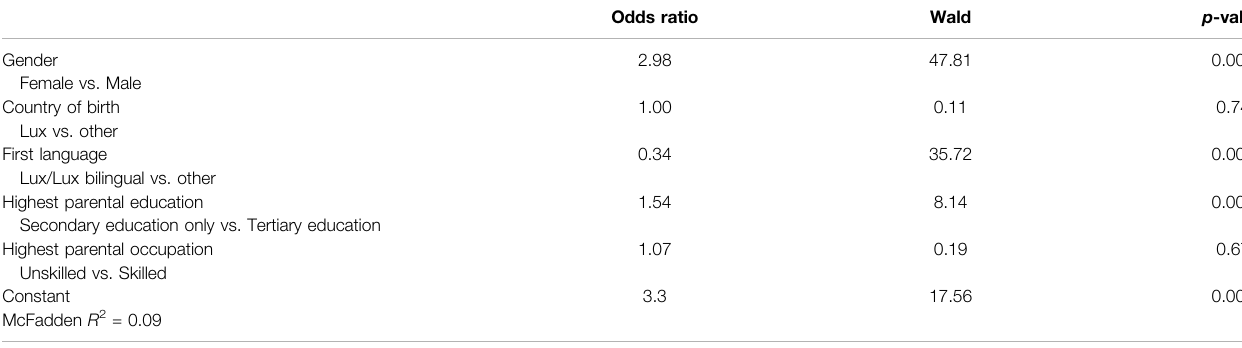
TABLE 2 | Demographic characteristics as predictors of admission.